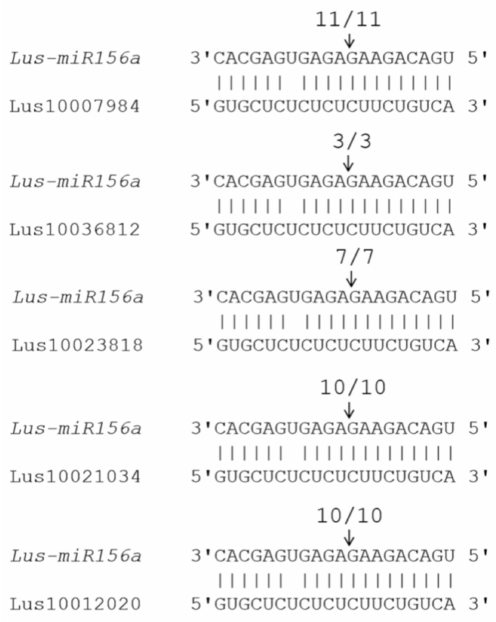
Figure 5. Mapping target mRNA cleavage sites by 5’-RLM-RACE. The arrows indicate the cleavage sites and the numbers show the frequency of clones sequenced.